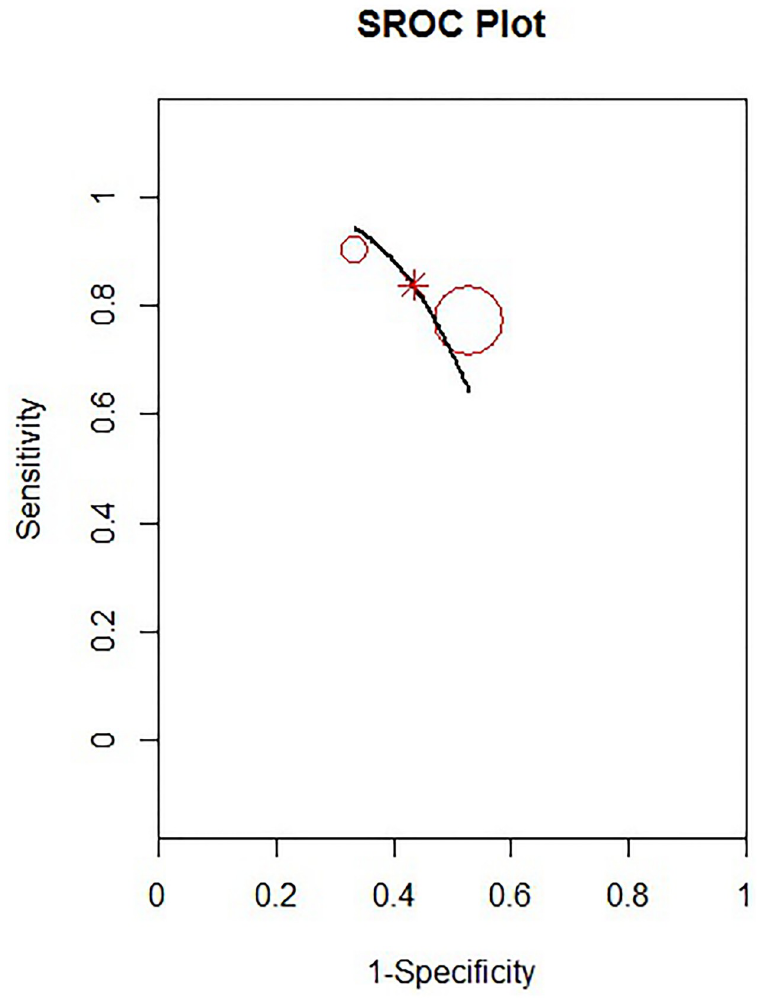
Fig 7. Summary ROC curve for POD4.